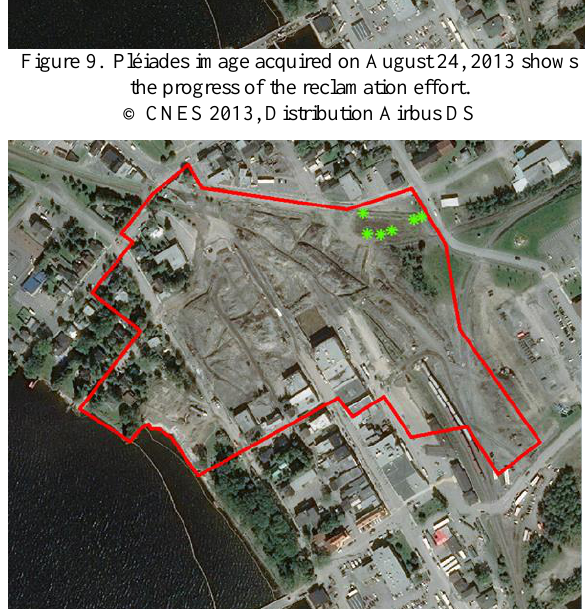
Figure 10. Pléiades image Acquired on September 6, 2013 shows the removal of a stand of trees highlighted in